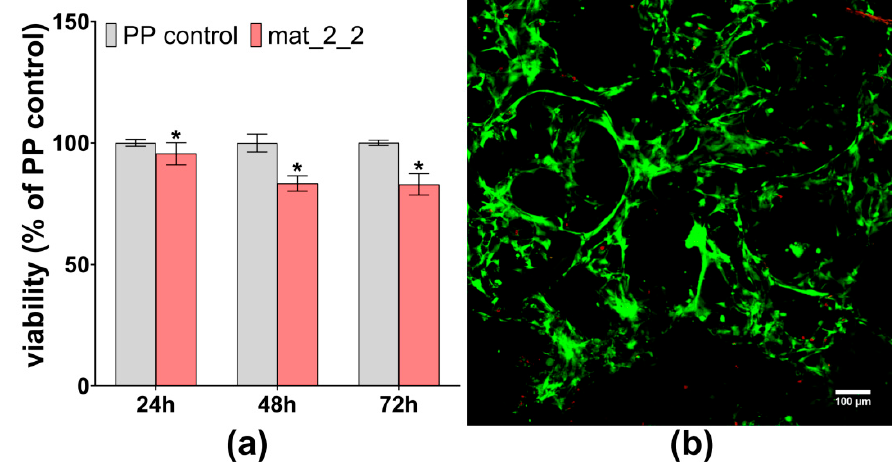
Figure 4. Cytotoxicity evaluation of the mat_2_2 scaffold against MC3T3-E1 cells: ( a ) MTT test after 24-h, 48-h, and 72-h exposure to the extracts (PP control—polypropylene extract as negative control of cytotoxicity; *statistically significant results compared to PP control, p < 0.05, unpaired t-test); ( b ) confocal laser scanning microscope (CLSM) image showing live/dead staining of cells cultured on the surface of the mat_2_2 scaffold (green fluorescence—viable cells, red fluorescence—dead cells, magnification 100×, scale bar = 100 µm).